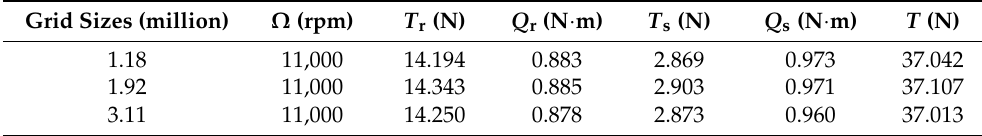
Figure 5. Diagram of background grids with different grid sizes: ( a ) 1.04 million, ( b ) 1.65 million. Table 2. Performance comparison of the ducted fan with different background grids. Table 1. Performance comparison of the ducted fan with different blade grids. Grid Sizes (million)